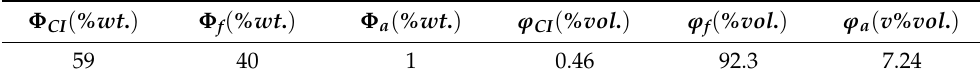
Table 1. Mass ( Φ ) and volumetric ( ϕ ) fractions for MS i , where i = 1, 2, and 3 denote sample numbers.